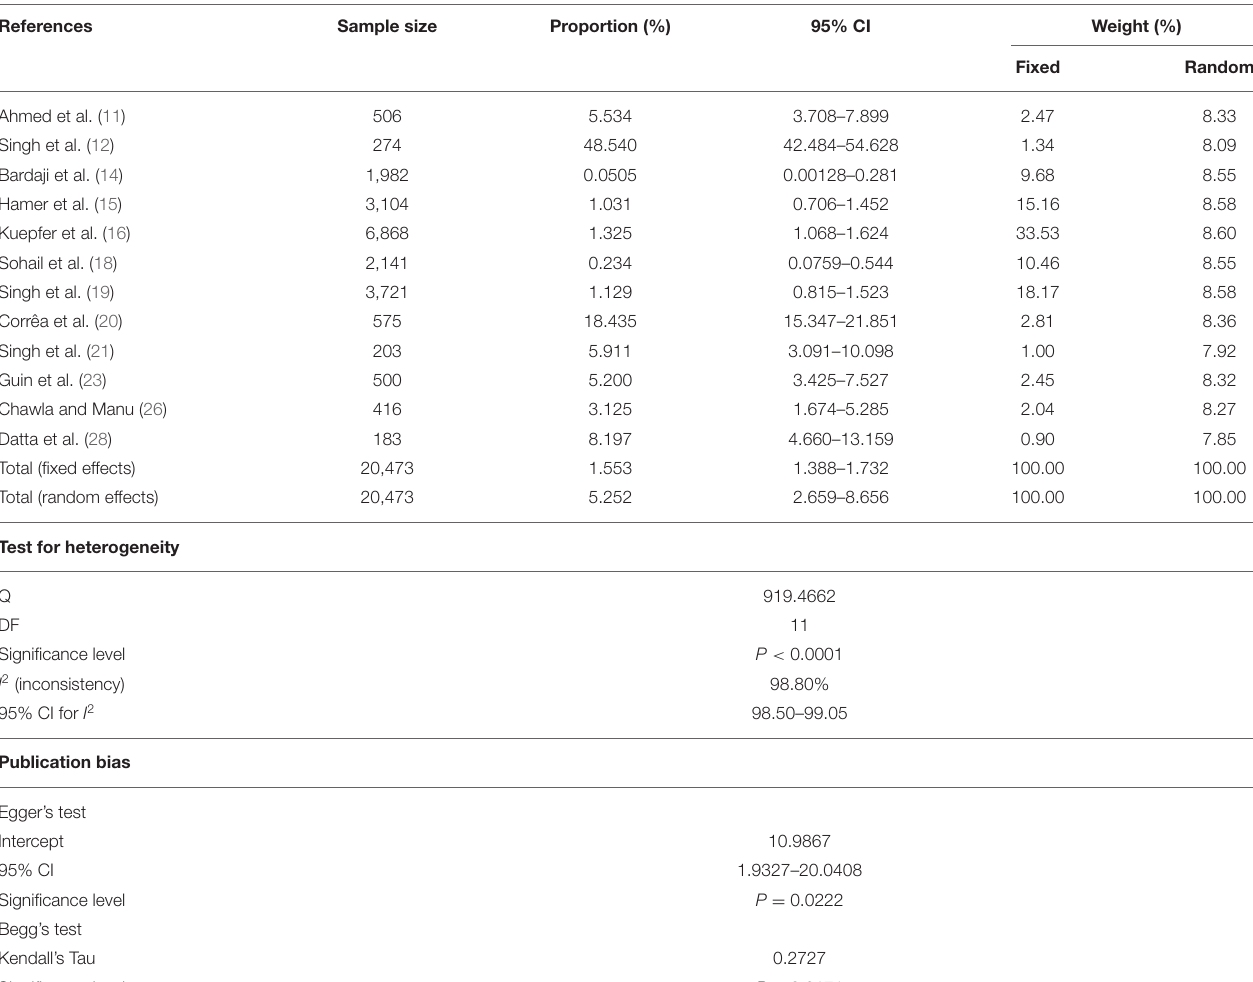
TABLE 8 | Pooled prevalence of Plasmodium falciparum infection in pregnant females.